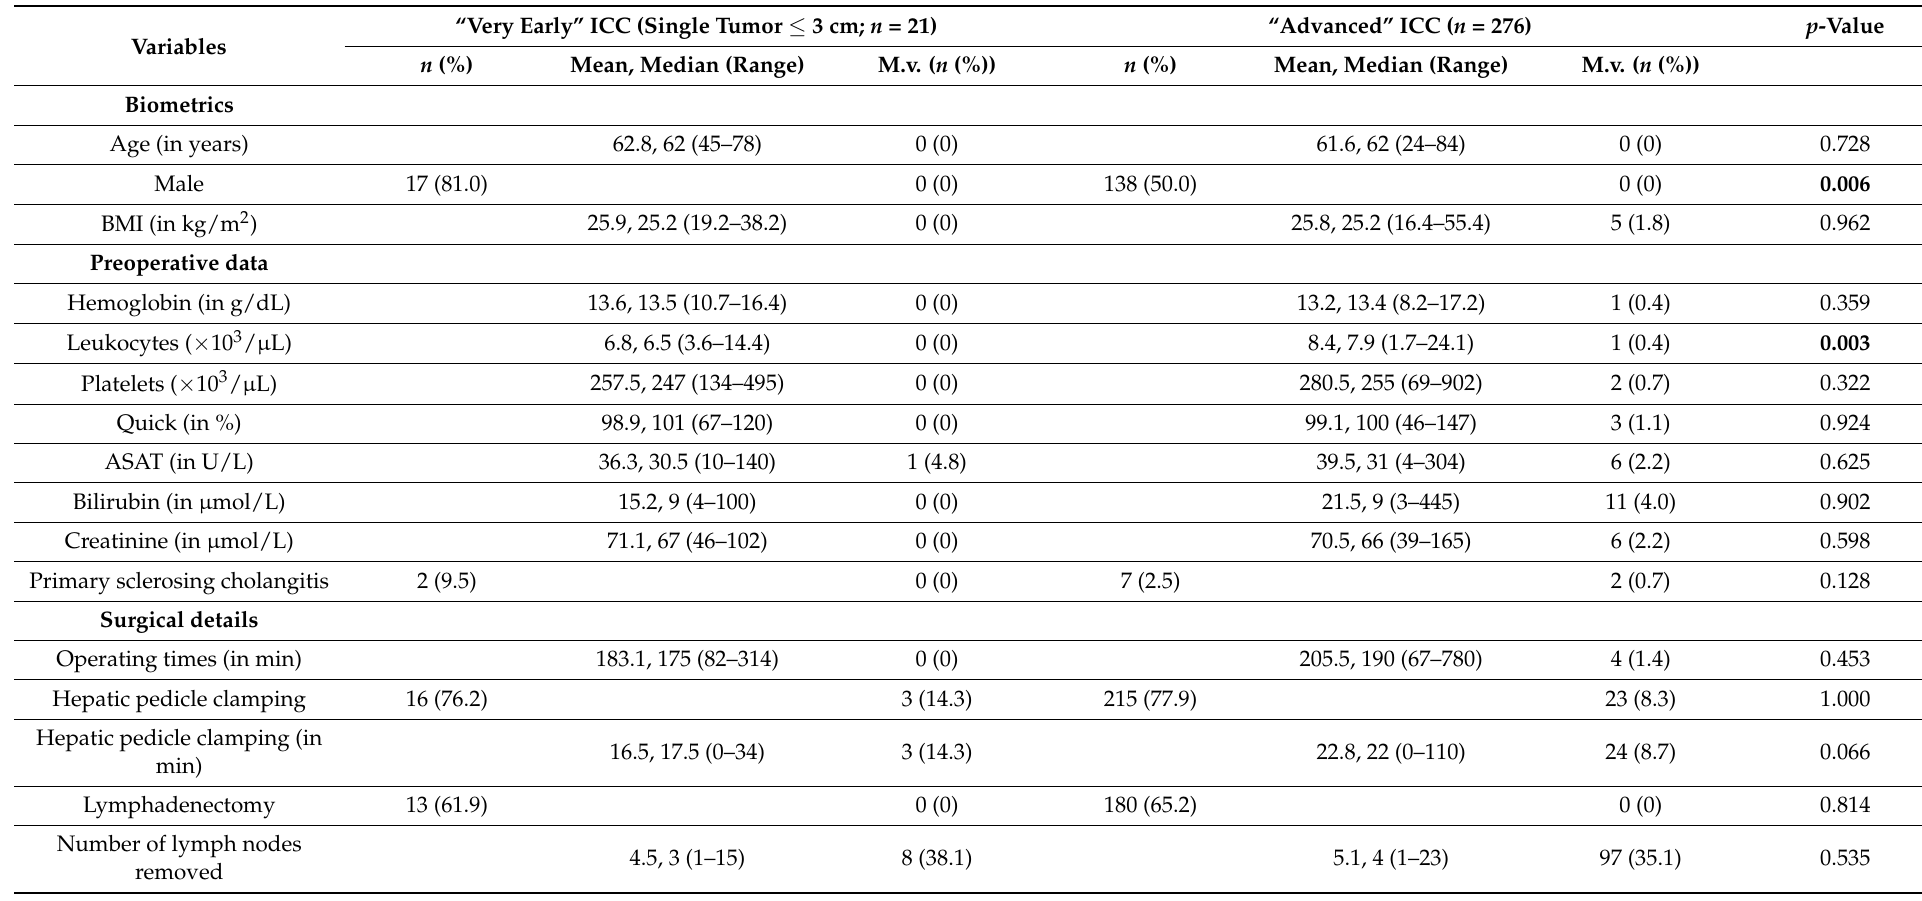
Table 1. Perioperative variables of patients with “very early” intrahepatic cholangiocarcinoma (ICC) including a comparison to a control group undergoing resection with curative intent.